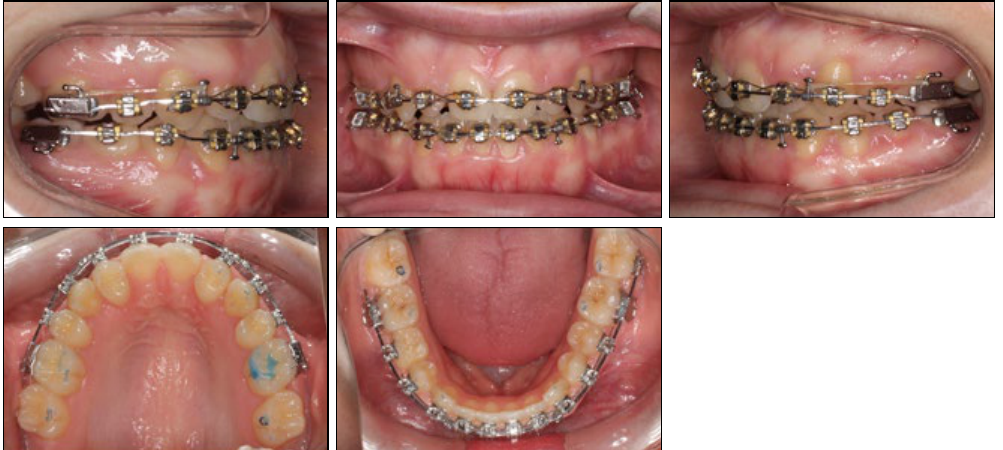
Figure 8. Treatment progress intraoral photographs. Last treatment